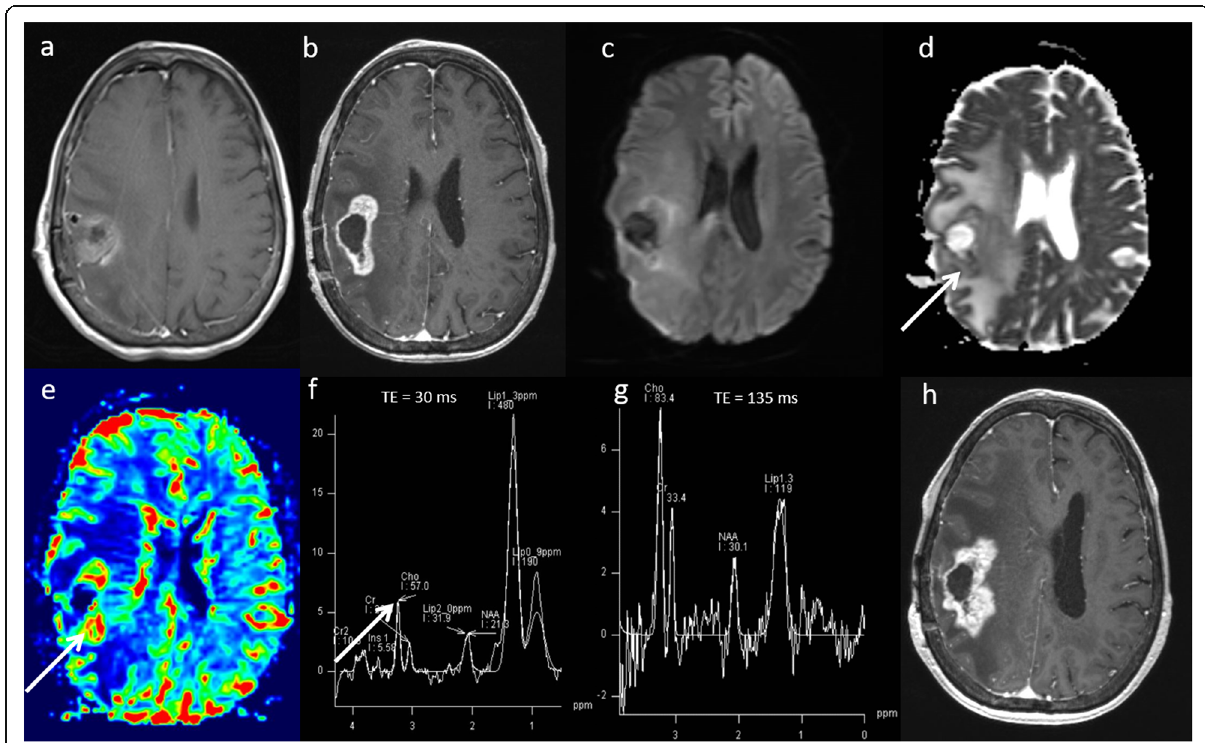
Fig. 9 Glioblastoma — true progression. a Immediate post-operative contrast-enhanced T1-weighted scan following resection of a right fronto- parietal glioblastoma. b Conventional post-contrast T1-weighted image one month after chemoradiotherapy treatment demonstrates increase in the enhancing lesion size with associated oedema. Multiparametric MRI at this timepoint demonstrates: c , d areas of low ADC (903 × 10 − 6 mm 2 s − 1 , arrow), ( e ) a high rCBV ratio (3.0, arrow) on PWI, ( f , g ) a high Cho/Cr ratio (2.3, arrow), high Cho/NAA ratio and presence of lipid/lactate